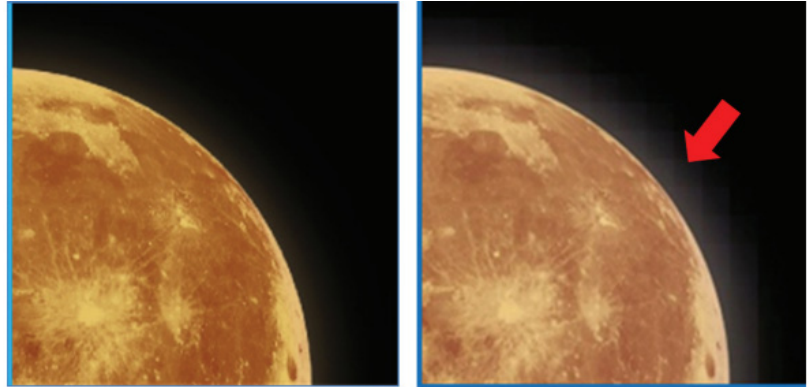
Figure 1. Halo effect caused by mini-LED backlight [12]. Direct-lit backlight is still the most commonly used backlighting method for LCD. It usually uses a sufficiently thick diffuser plate or leaves a large enough air gap between the backplane and the diffuser plate to convert the point light source into a uniform surface light source [13]. Both the diffuser and the air gap increase the thickness of the backlight module. The large increase in the number of Mini-LEDs can achieve uniform illumination and reduce the module thickness. However, that will lead to a higher cost, which hinders the development of LCD to ultra-thin displays. In addition, how to eliminate the “hot spots” generated in the process of reducing the module thickness is also a challenge